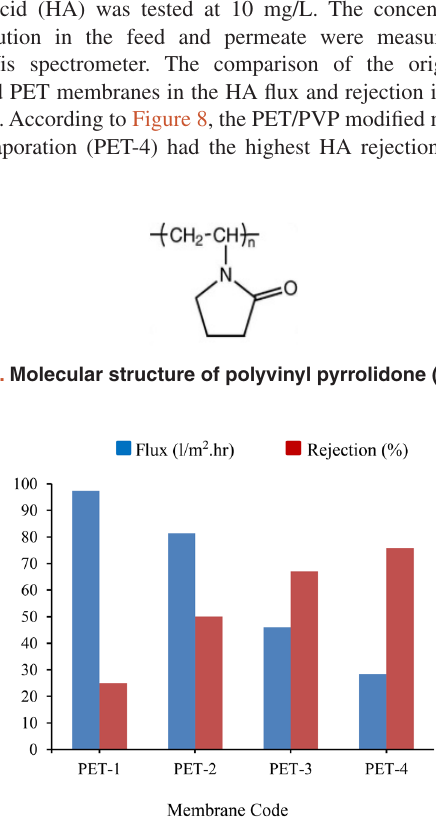
Figure 8. Filtration performance of PET membrane by using humic acid solution. PET-1, no added PVP or evaporation; PET-2, no added PVP and 7 minutes of evaporation; PET-3, added PVP and no evaporation; added PET-4, PVP and 7 minutes of evaporation. Three repeats of each membrane type were performed.